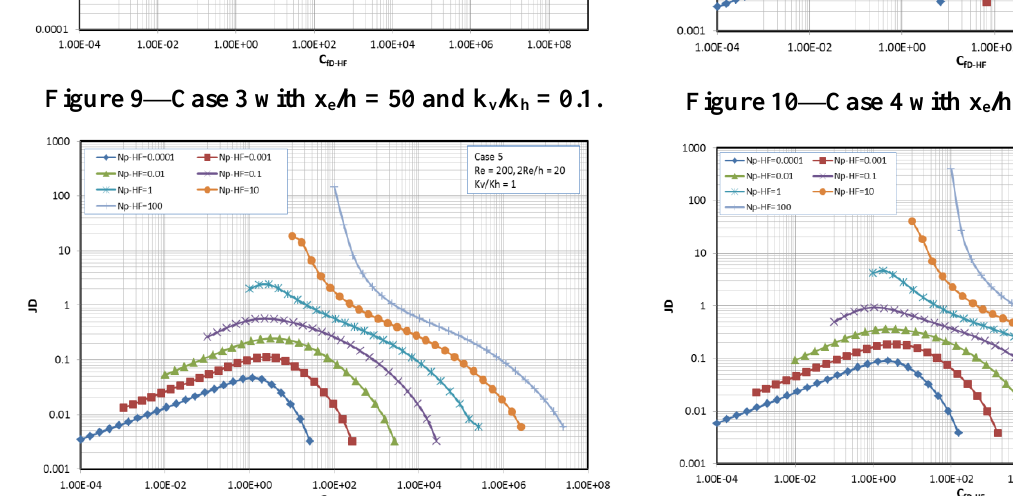
/h = 20 and k /k = 1. Figure 12—Case 6 with x e /h = 50 and k v /k h = 1. e v h